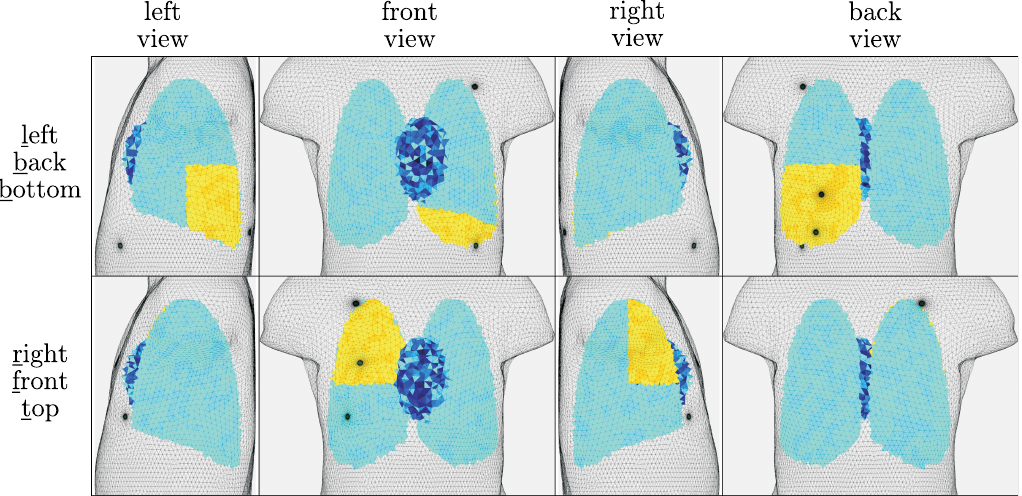
Fig.2: Finite element model used in this study (model from [14]). The lungs were split into eight regions of interest. For each ROI, a specific tetrapolar electrode configuration was placed at the body surface. In this paper, the results for the regions of interest left, back, bottom and right, front, top region will be presented. The respective electrode configurations are based on the results in [6] and shown from different views in the two rows. The focused ROI is highlighted in yellow.